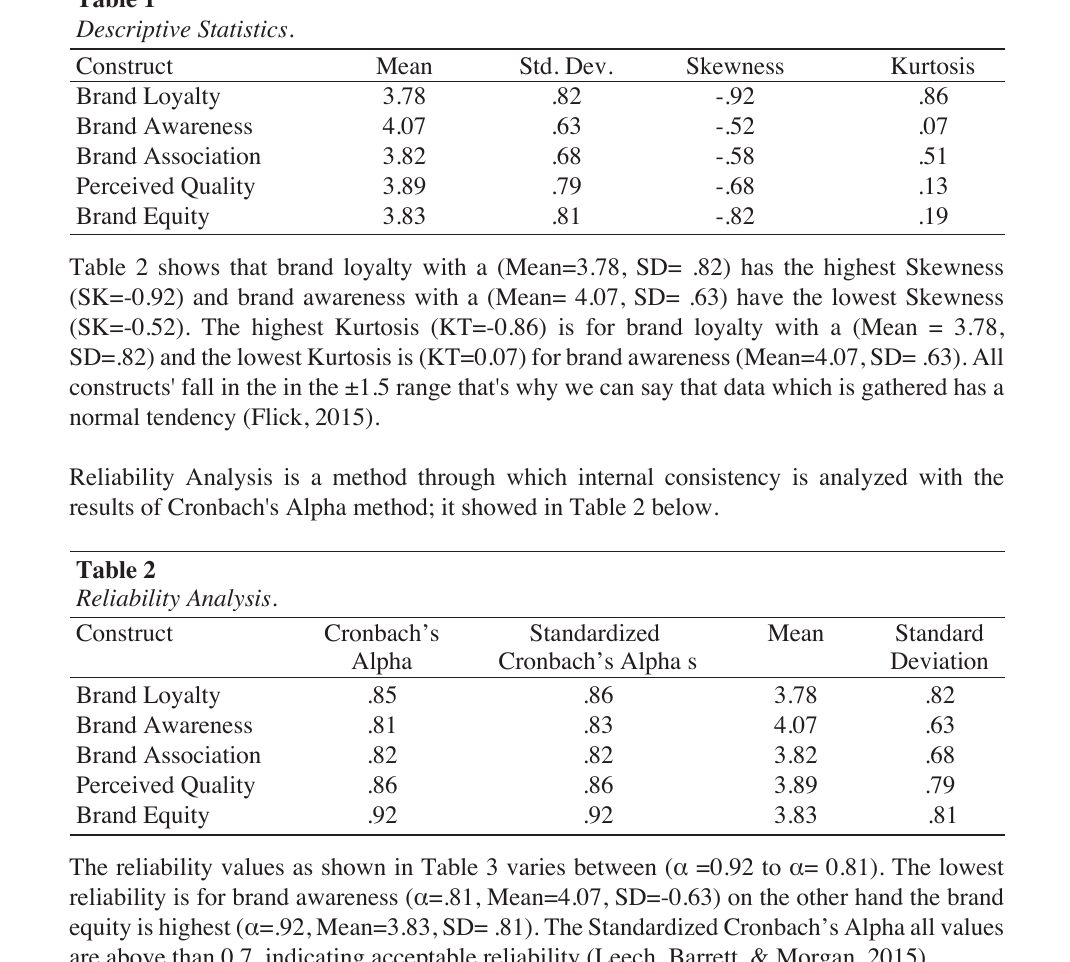
Descriptive Statistics.